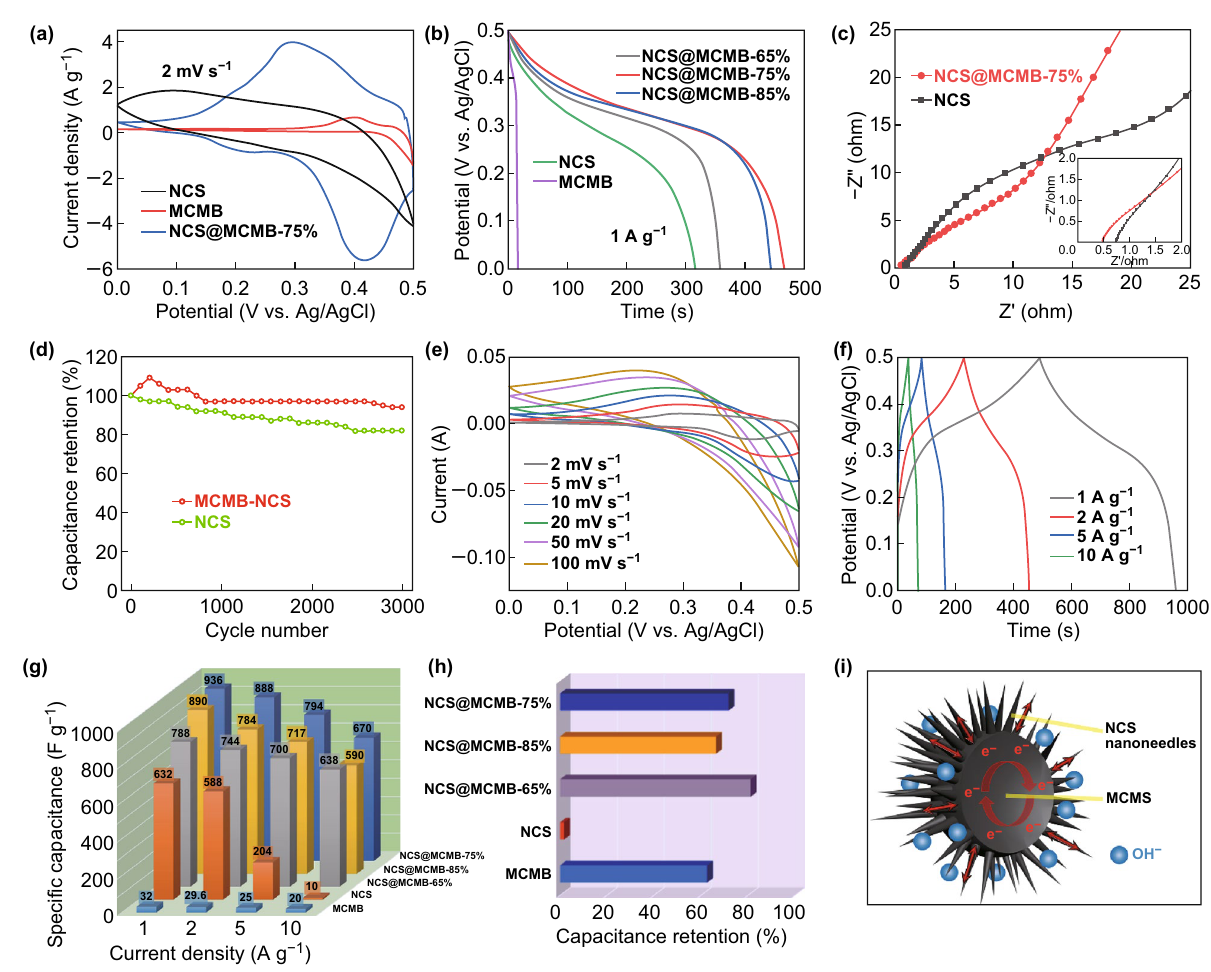
Fig. 6 a CV curves at a scanning rate of 2 mV s −1 , b GCD curves at a current density of 1 A g −1 , c EIS spectra, and d cycling tests of NCS@ MCMB and NCS. Typical e CV and f GCD curves of NCS@MCMB-75%. g Specific capacitance and h capacitance retention of NCS@MCMB, MCMB, and NCS at increased current densities. i Schematic diagrams illustrating the kinetic advantages of the NCS@MCMB composite in electrochemical energy